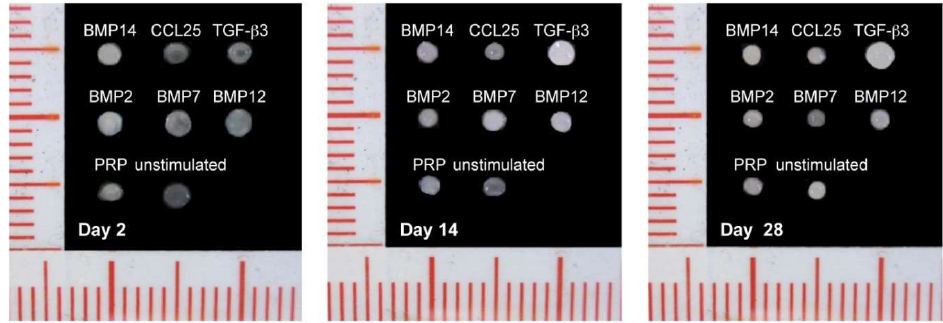
Figure 3. Pellet formation of AF cells (exemplarily donor 7, 100 ng/mL supplemented factor or 2.5% PRP or unstimulated) showed an increase of stiffness and a decrease in size, except of TGFβ3 stimulated pellets. There, also an increase of size was visible (scale: scale line distance = 1 mm; main scale line distance = 5 mm).